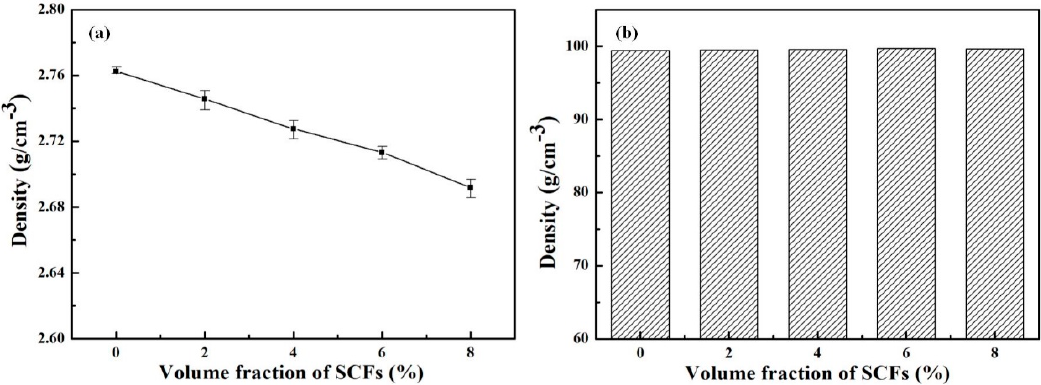
Figure 2. The ( a ) measured density and ( b ) relative density for the composites with different volume fraction of SCFs.